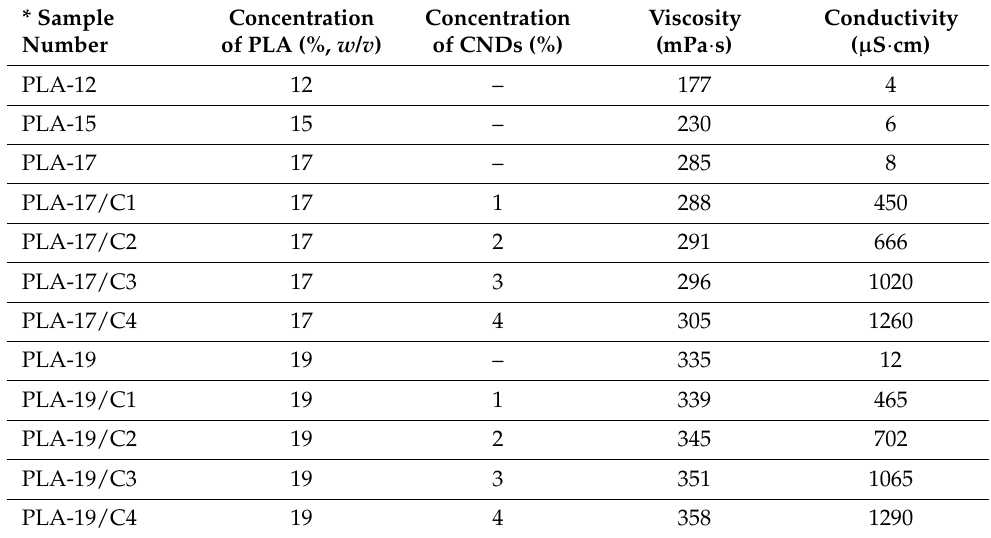
Table 1. Design of experiment, viscosity, and conductivity of different solutions of PLA in DMF.